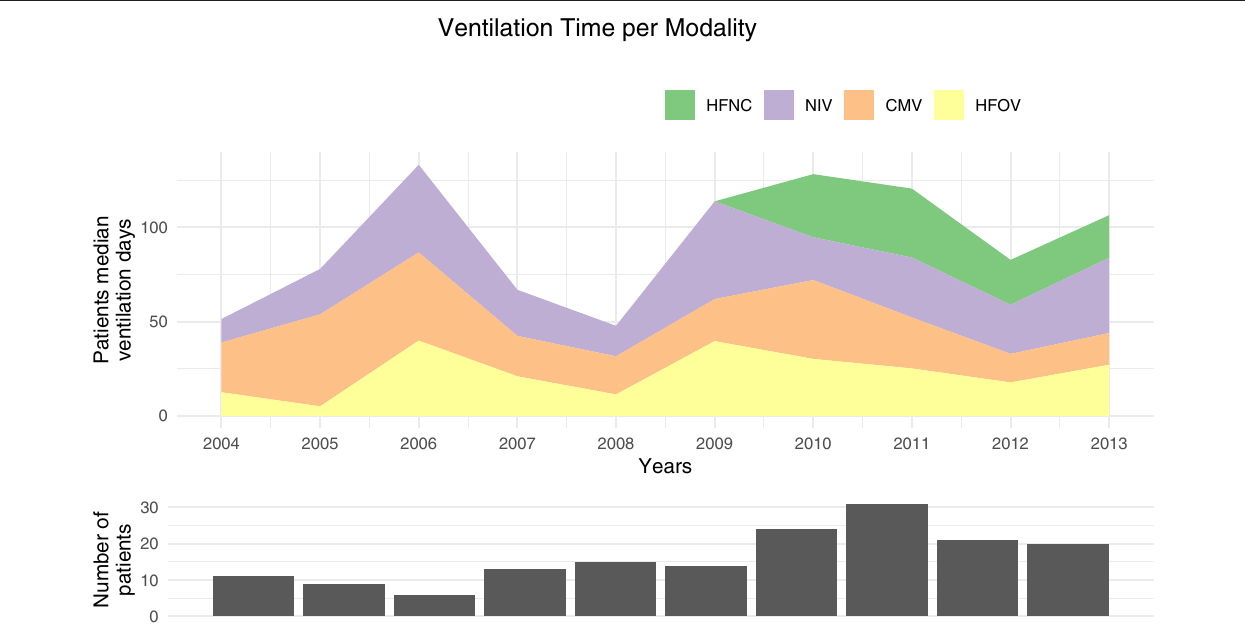
three decades ago, but very few recent studies presented an updated description of the situation, including the increased use of modern ventilation modes, such as high flow nasal cannula